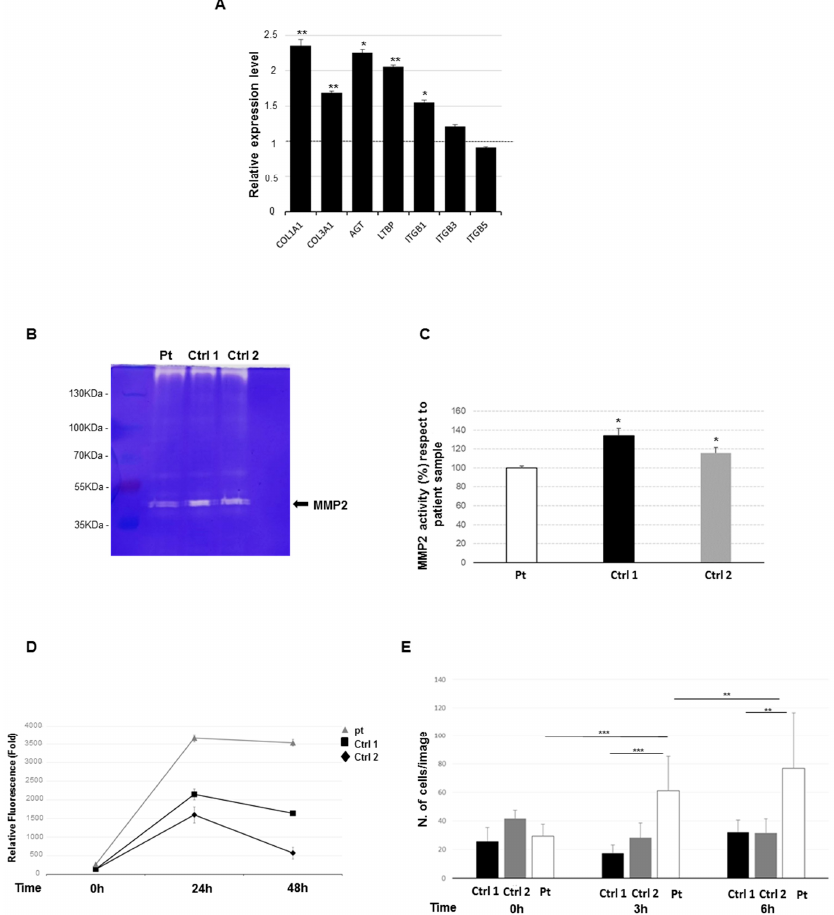
Figure 4. Analysis of fibrotic profile and proliferation study. ( A ) Trans-activation of pro-fibrotic genes was assessed by qPCR monitoring endogenous levels of COL1A1 , COL3A1 , AGT , LTBP1 , IGTB1 , IGTB3, and IGTB5 . The fold change value is relative to the mean expression levels of two controls, which were set as value 1 and showed by a dashed line on the histogram. Scale bars represent standard errors. Values are expressed as mean ± SEM (* p < 0.05, ** p < 0.03, n = 3). ( B ) Representative gelatin zymography for matrix metalloproteinase-2 (MMP2), from patient (Pt) and two control (Ctrl) lines. The molecular weight is indicated. ( C ) Quantification of MMP2 activity based on zymography assay. Experiments were performed in triplicate, * = p < 0.05. ( D ) Graphic result of viability assay (PrestoBlu) in patient and controls cells. The rate of proliferation viability was annotated for 48 h. Results were statistically analyzed by ANOVA test. ( E ) Quantitative analysis of cell migration is given as the mean ± SD of cells per field. Results were normalized against the control gel condition. ** p < 0.03, *** p <